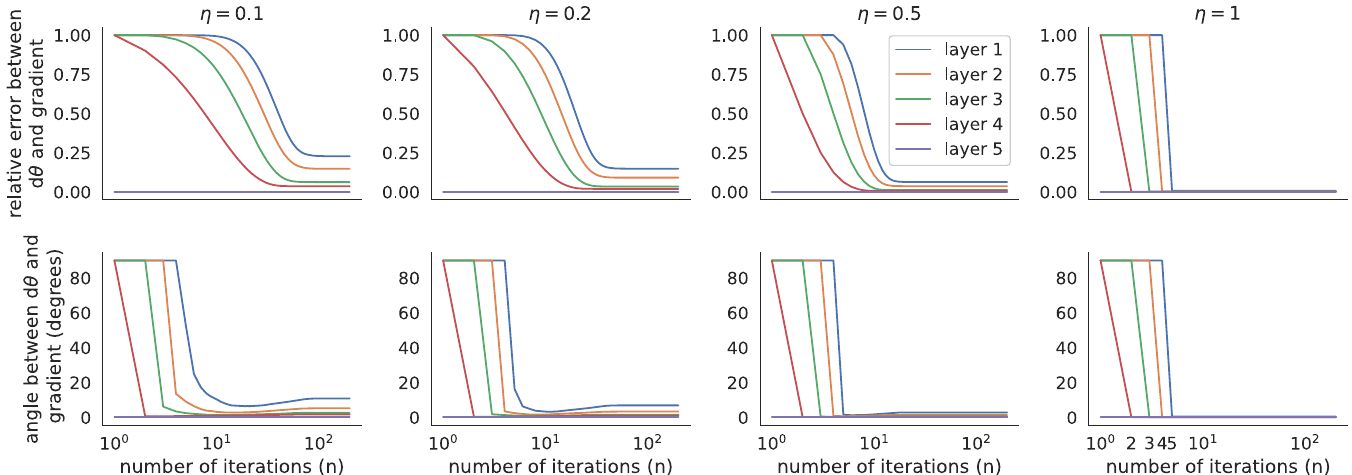
Fig 4. Comparing parameter updates from predictive coding modified by the fixed prediction assumption to true gradients in a network trained on MNIST. Relative error and angle between dθ produced by predictive coding modified by the fixed prediction assumption (Algorithm 3) as compared to the exact gradients computed by backpropagation (relative error defined by k dθ k / k dθ k ). Updates were computed as a function of the number of iterations, n , used in Algorithm 3 pc − dθ bp bp for various values of the step size, η , using the model from Fig 3 applied to one mini-batch of data. Both models were initialized identically to the pre-trained parameter values from the backpropagation-trained model in Fig 3. In the rightmost panels, some lines are not visible where they overlap at zero. Parameter updates quickly converge to the true gradients when η is larger.